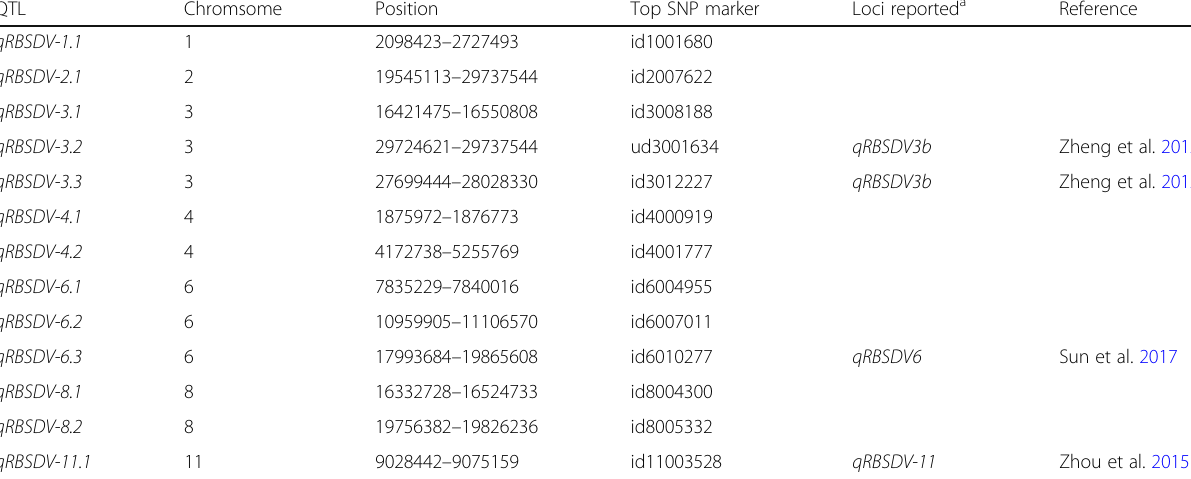
Table 2 QTLs for the RBSDV